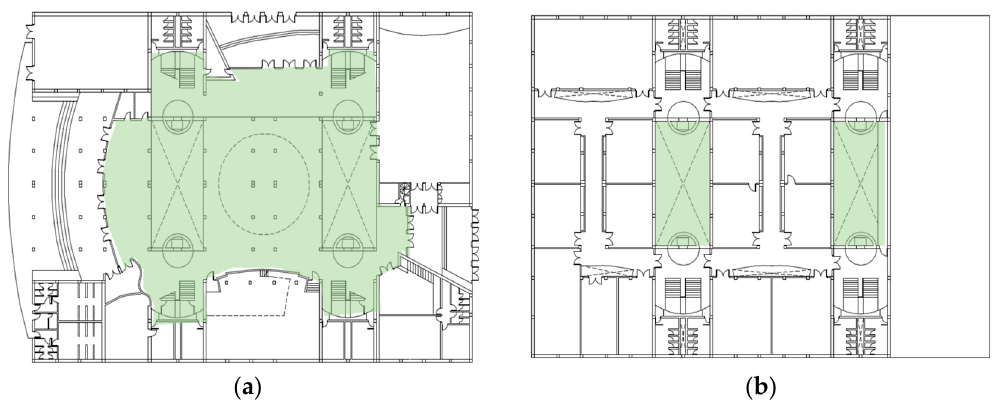
Figure 2. Set of drawings: ( a ) Ground floor +0.00 m; ( b ) Second floor +8.30